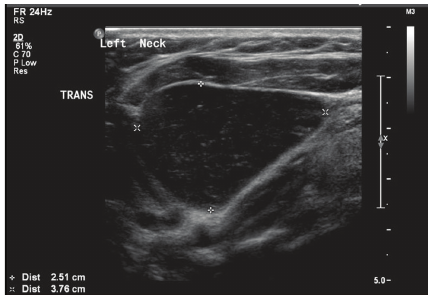
Figure 2: Ultrasound-transverse view showing the large cystic lesion.